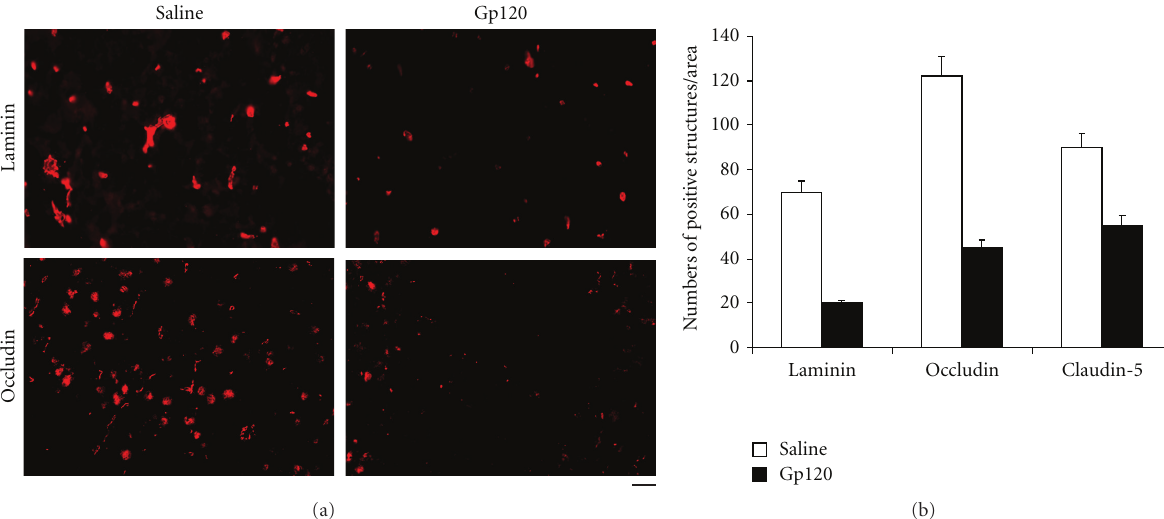
Figure 4: Gp120 induced a degradation of vascular basement membrane and vascular tight junctions. (a) After intra-CP injection of 500ng gp120, fewer laminin- (a basement membrane protein) and occludin-(a tight junction protein) positive structures were seen. (b) Graph showing a significant reduction of laminin-, occludin-, and claudin-5-(another tight junction protein) positive structures in CPs injected with 500 ng gp120. Bar: (a) 60 μ